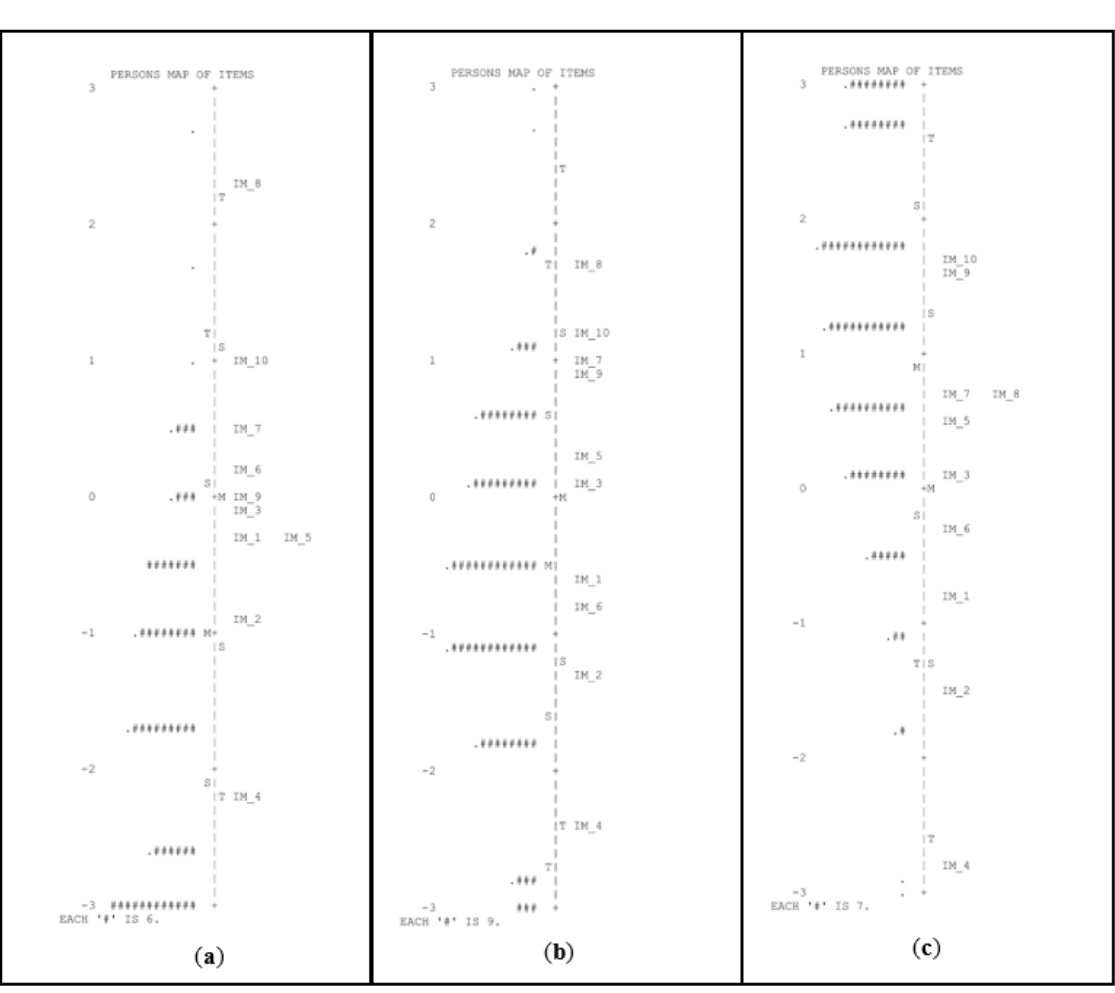
Figure 4. Person–item maps for the task of concepts about print in pre-K ( a ), kindergarten ( b ), and first grade of primary school ( c ) . # Refers to the number of persons.